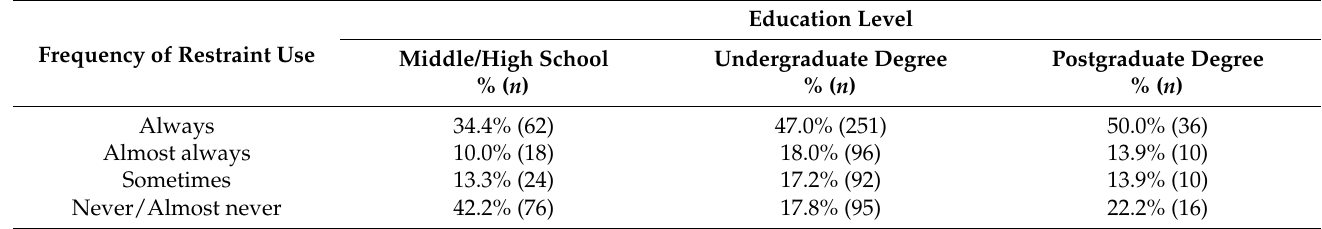
Table 4. Participants’ education level and frequency of restrai nt use for their eldest child.